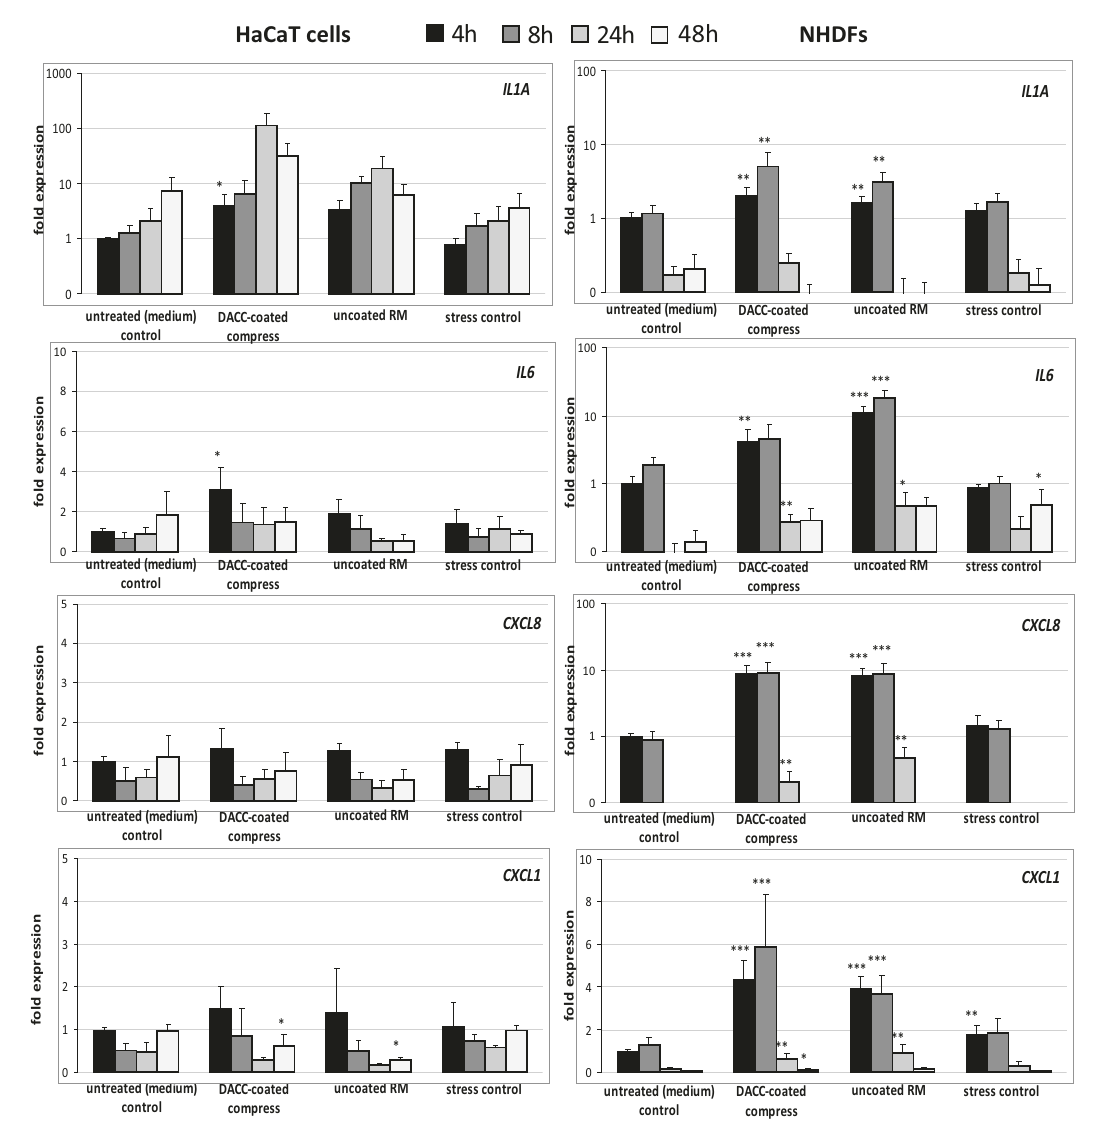
Fig. 5 Treatment impact of DACC and uncoated RM on gene expression in keratinocytes (HaCaT cells) and fi broblasts (NHDF) during scratch wound healing compared to the untreated (medium) control and the stress control. Quantitative analyses of gene expression for the pro-in fl ammatory cytokine genes IL1A , IL6 , CXCL8 , and CXCL1 were performed at 4, 8, 24 and 48 hours (h). Relative gene